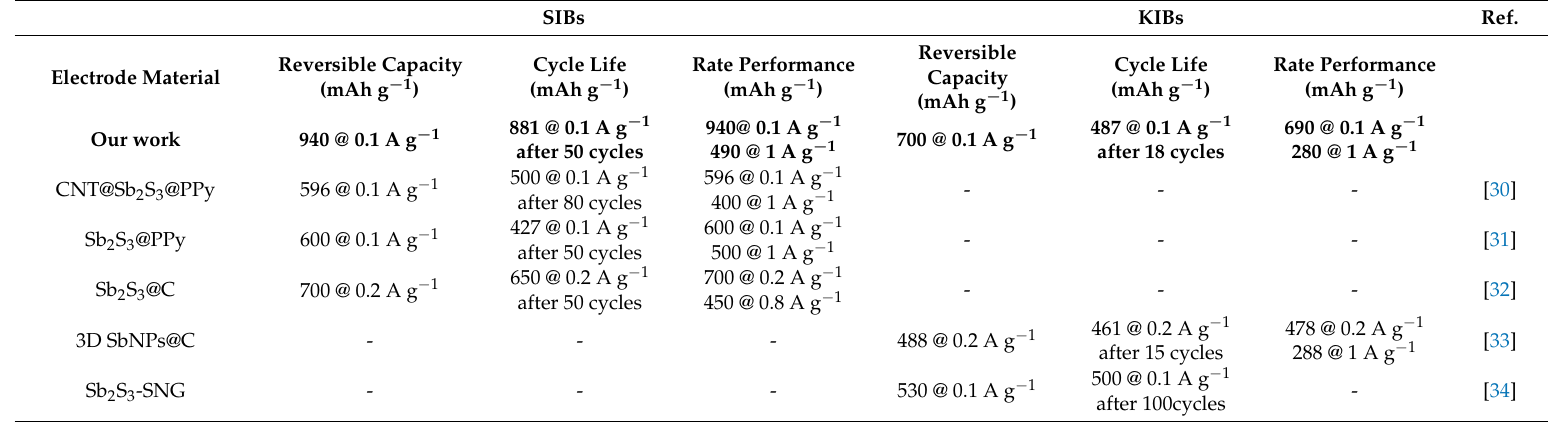
Table 1. Comparison of Sb 2 S 3 based anode materials for SIBs and KIBs in terms of their composition, reversible capacity, cycle life, and rate performance. SIBs KIBs